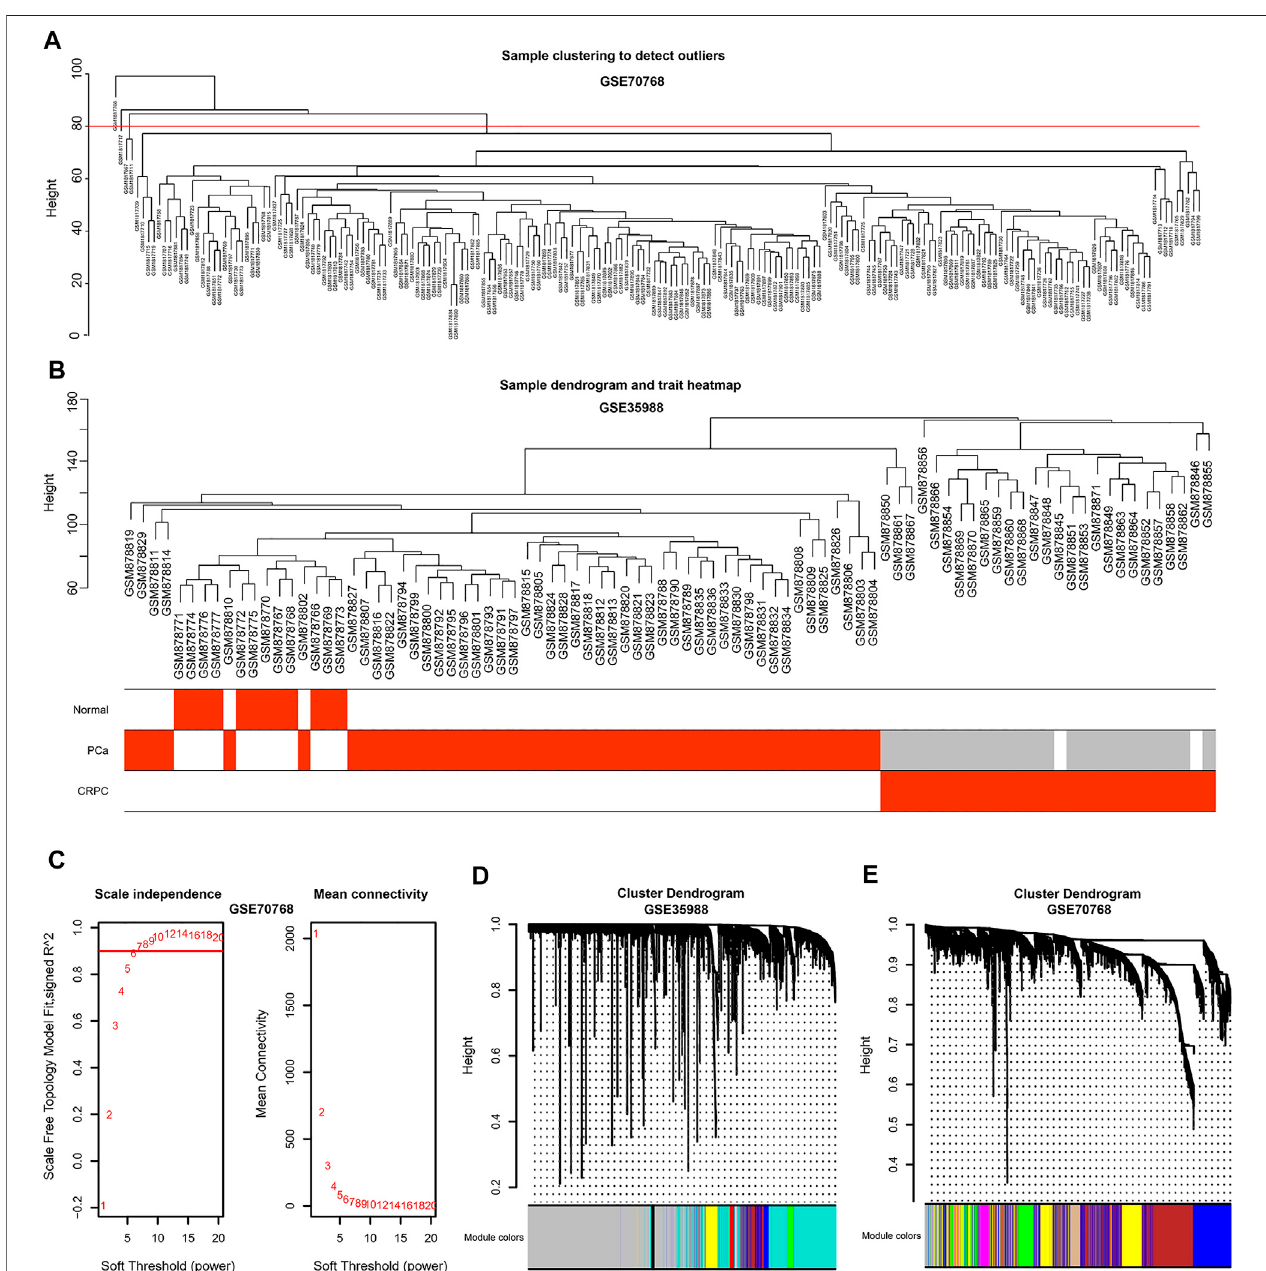
FIGURE 4 | Sample clustering by WGCNA (A) Detection of the outliers by sample clustering in GSE70768. (B) The sample dendrogram with trait heatmap in GSE35988 (C) Identi fi cation of the optimal soft threshold power ( β ) in GSE70768. (D,E) The gene clustering dendrogram and the merged modules in GSE35988 and